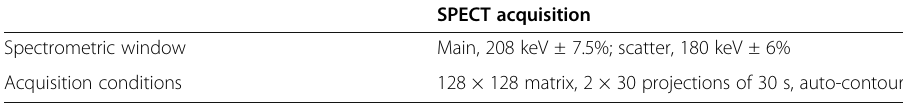
Table 2 Acquisition parameters for SPECT